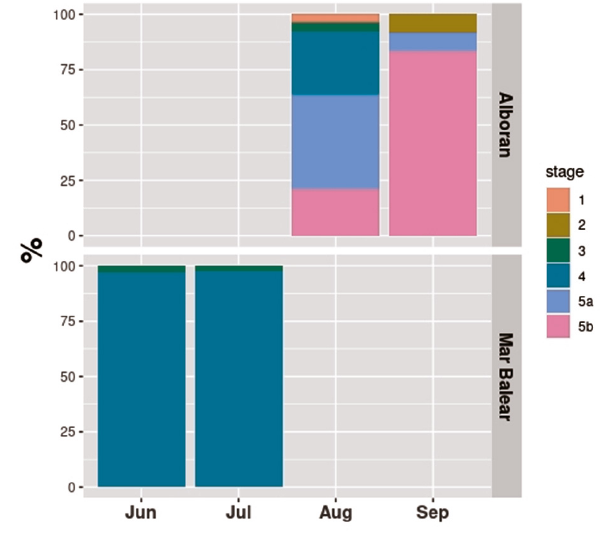
Fig. 4. – Monthly relative frequency of ovarian stages found by microscopic eamination in the Alboran Sea and the Balearic